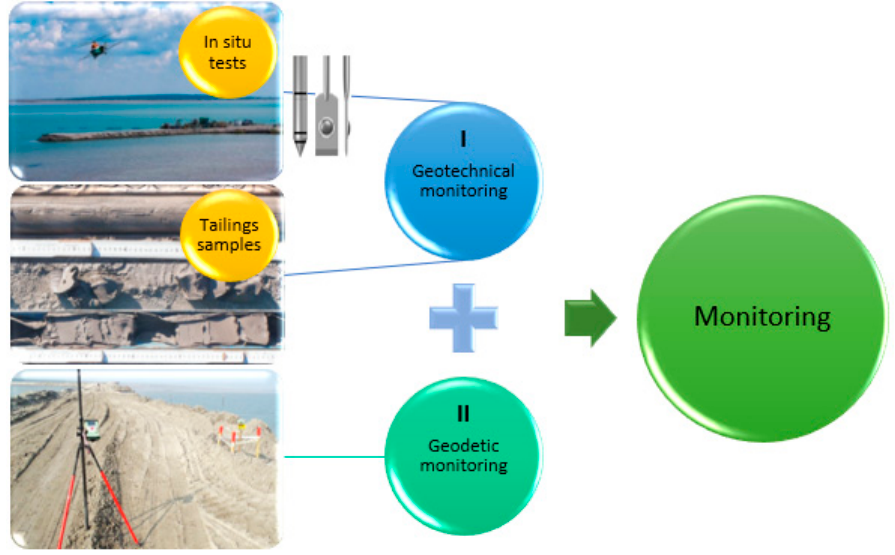
Figure 4. Monitoring components of the embankment and its subsoil.